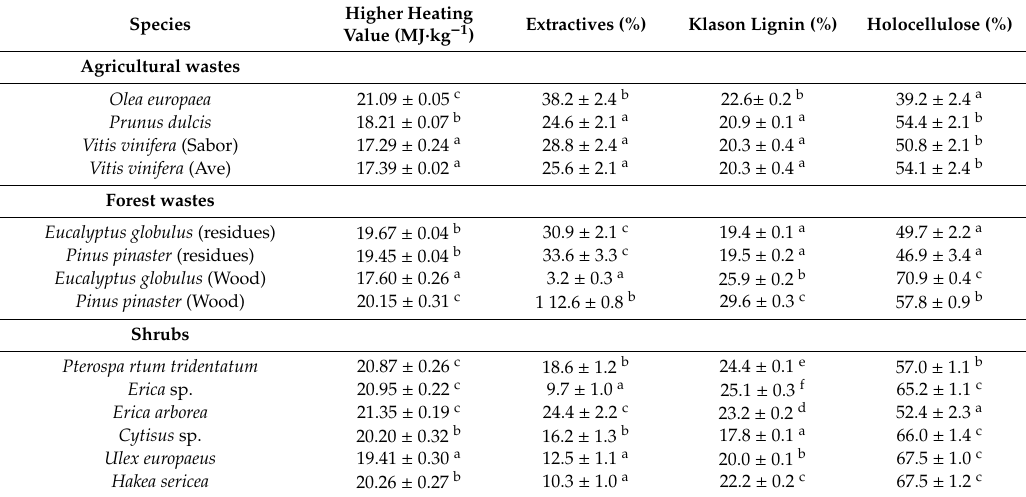
Table 1. Mean ± SD of Higher Heating Values and Macromolecules contents, of the samples. Note: mean values with the same letter within waste group are not significantly di ff erent for p < 0.05 by Duncan New Multiple Range test. Number of samples used in each species (n = 12).